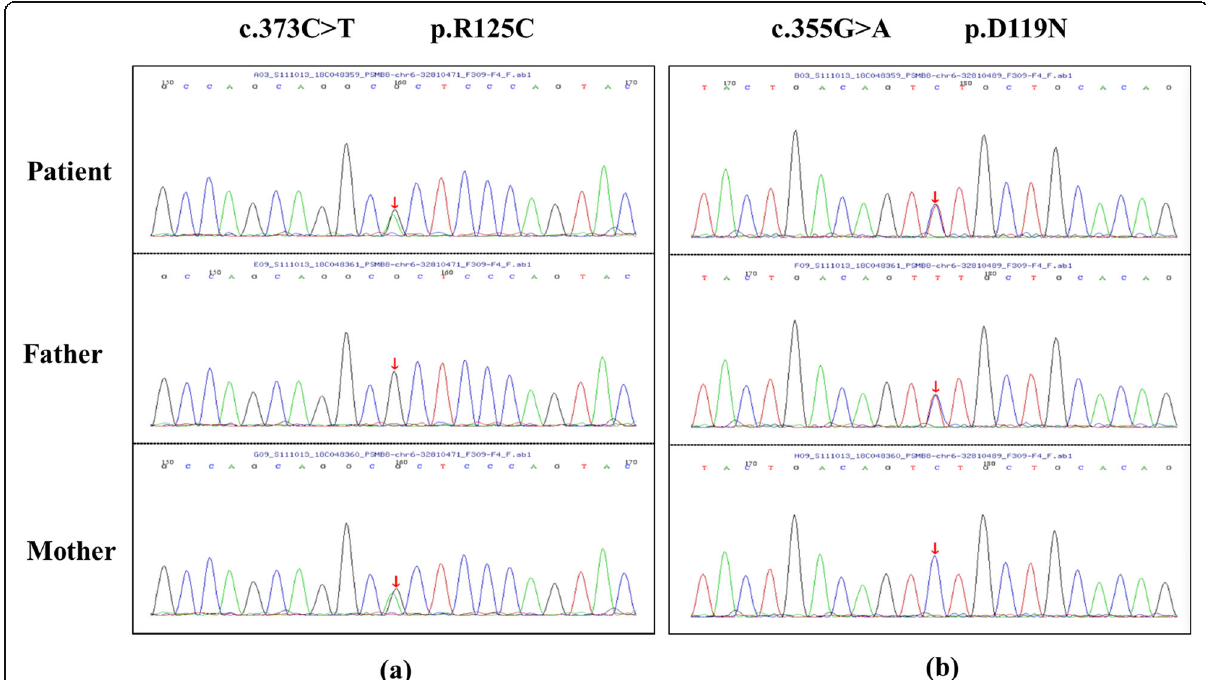
Fig. 3 Gene sequencing results. Sanger screening revealed a heterozygous c.373C > T (p.R125C) mutation a and c.355G > A (p.D119N) mutation b in exon 3 of the PSMB8 gene in the patient, a heterozygous c.373C > T (p.R125C) mutation in his mother and a c.355G > A (p.D119N) mutation in his